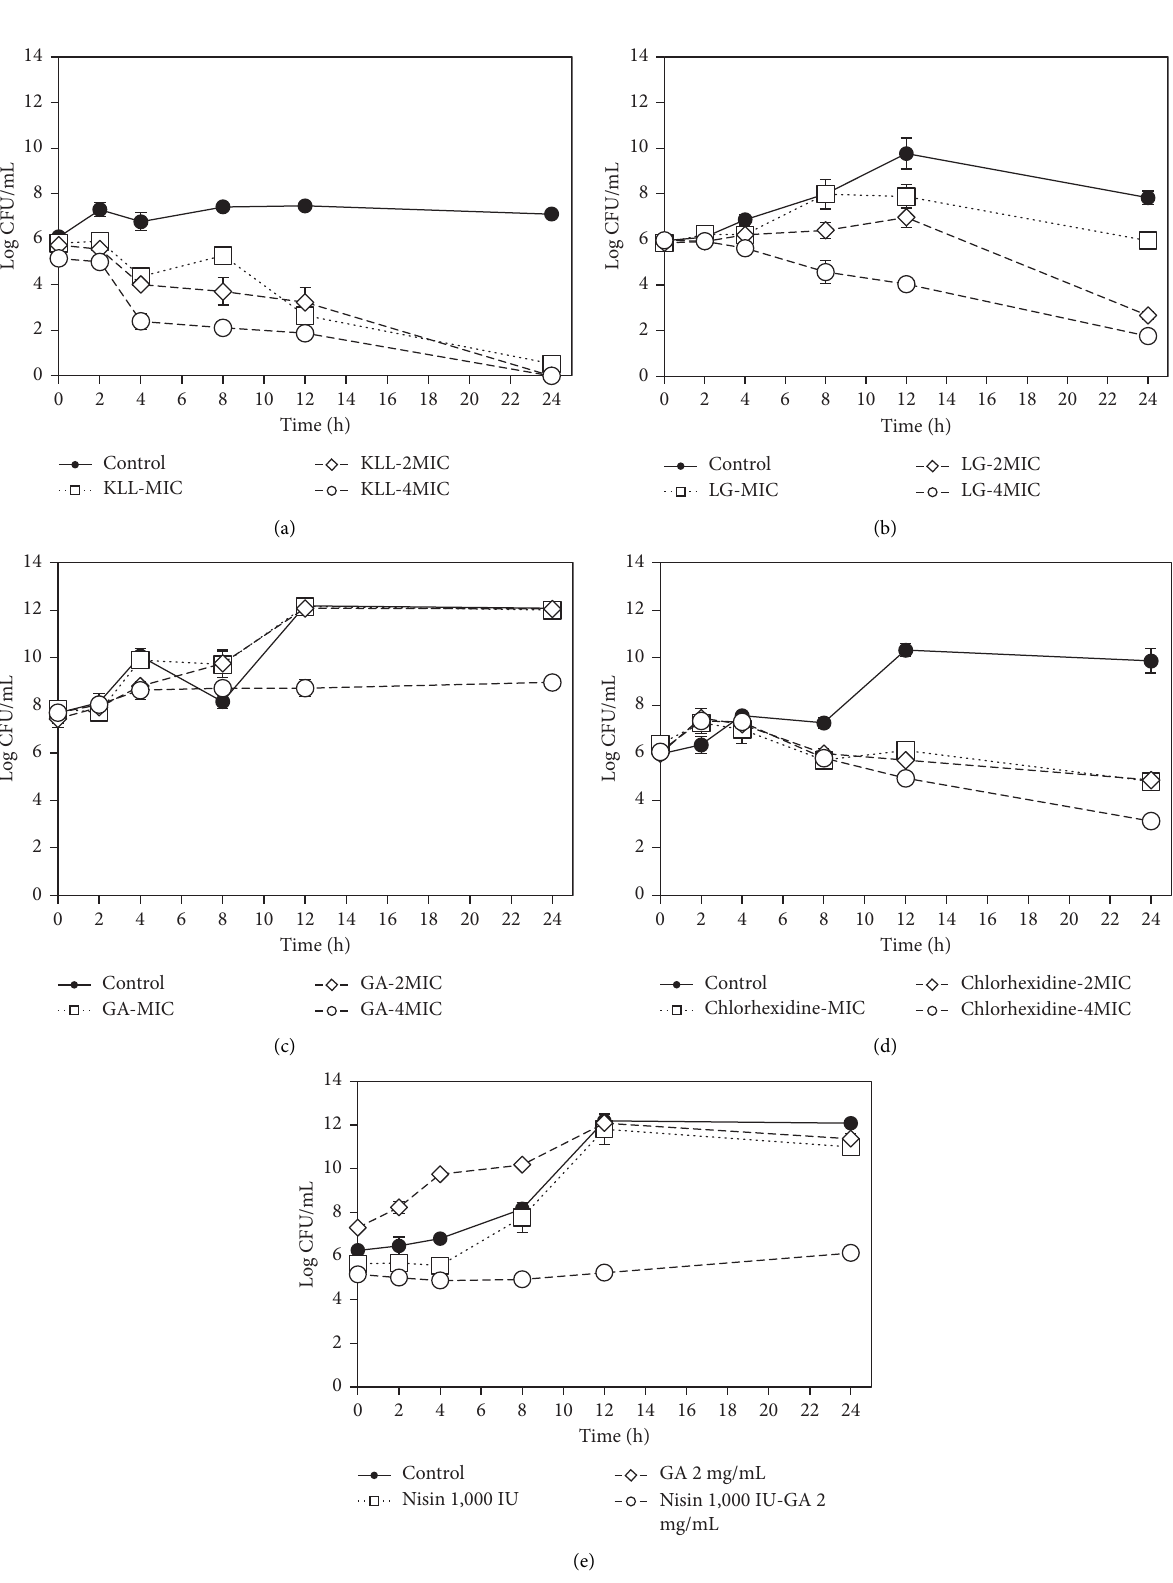
Figure 2: Time-kill curves of S. mutans ATCC 25175 after treatment with KLL oil (a), LG oil (b), GA (c), chlorhexidine (d), and the combination of nisin and GA (e). Each symbol indicates the mean ± SD of triplicate